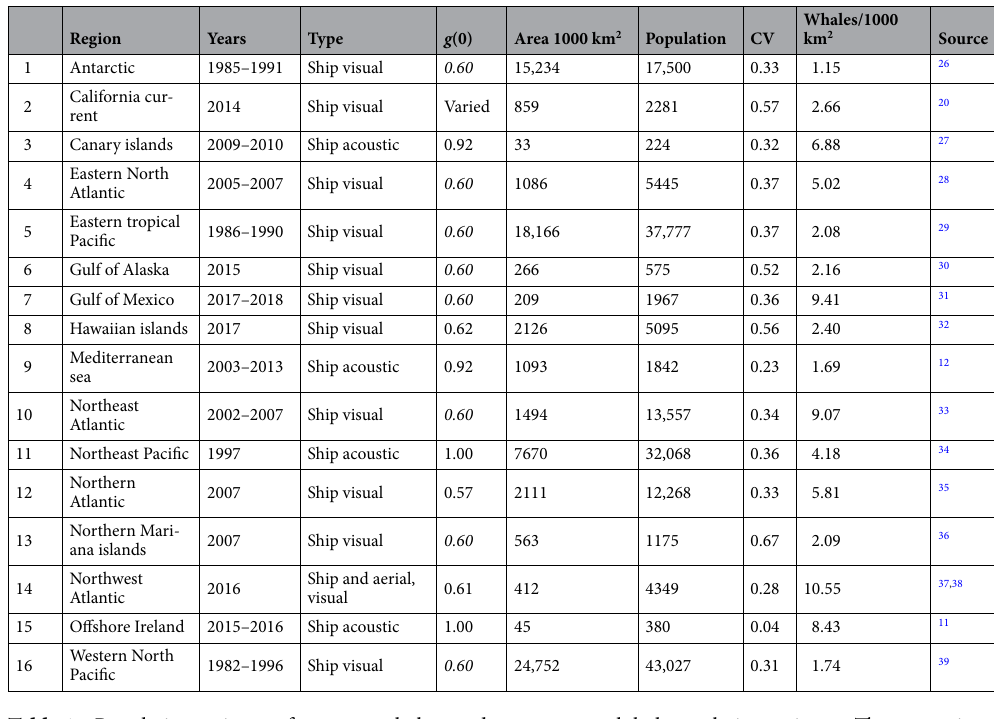
Table 1. Population estimates for sperm whales used to construct global population estimate. The correction for availability bias (i.e. whales being under water), g (0), is as given in the paper or, if not given, the assumed generic value ( italics ). The survey areas exclude waters less than 1000 m deep.